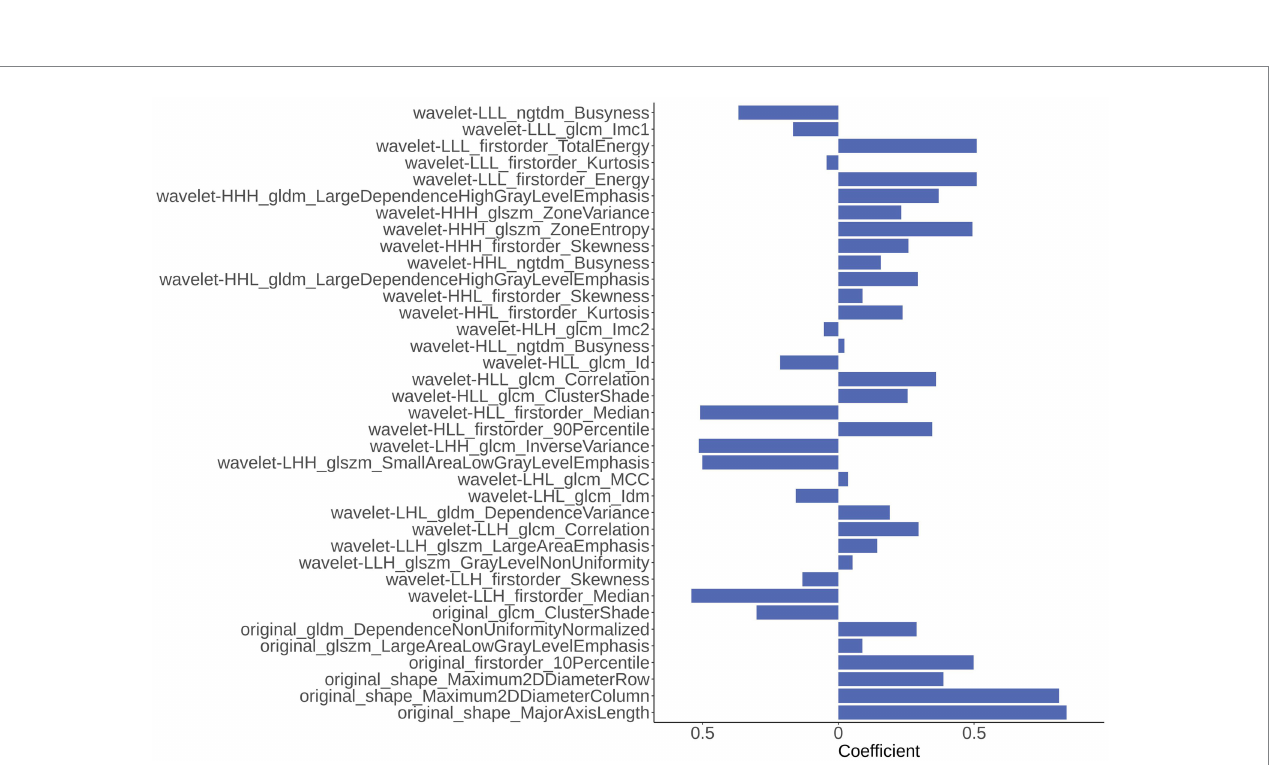
FIGURE 4 The importance of 37 radiomics features generated from Least Absolute Shrinkage and Selection Operator